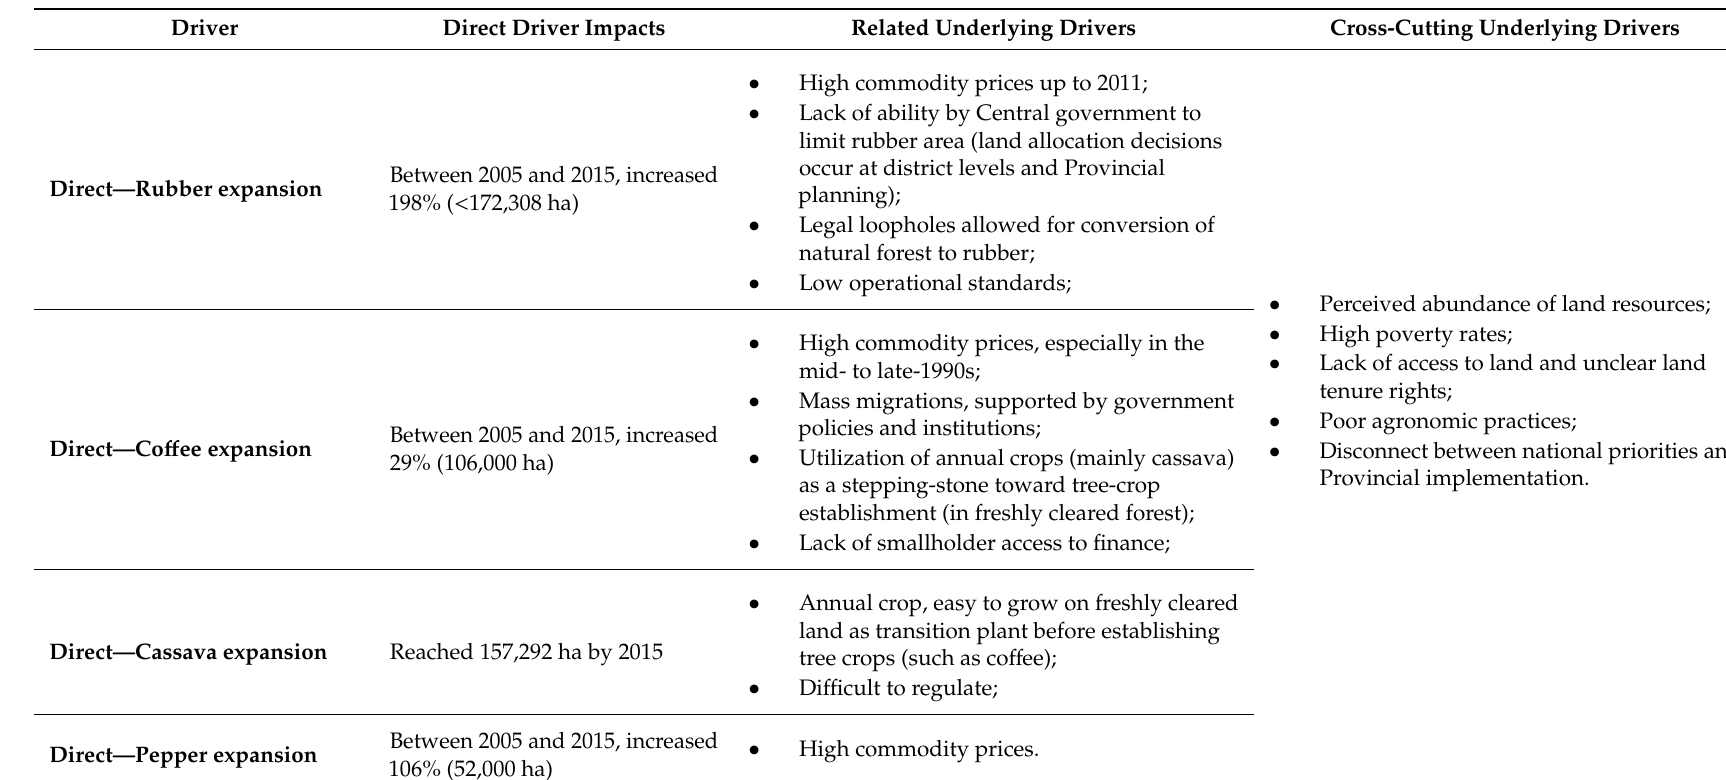
Table 2. Direct and underlying drivers of deforestation in the Central Highlands of Viet